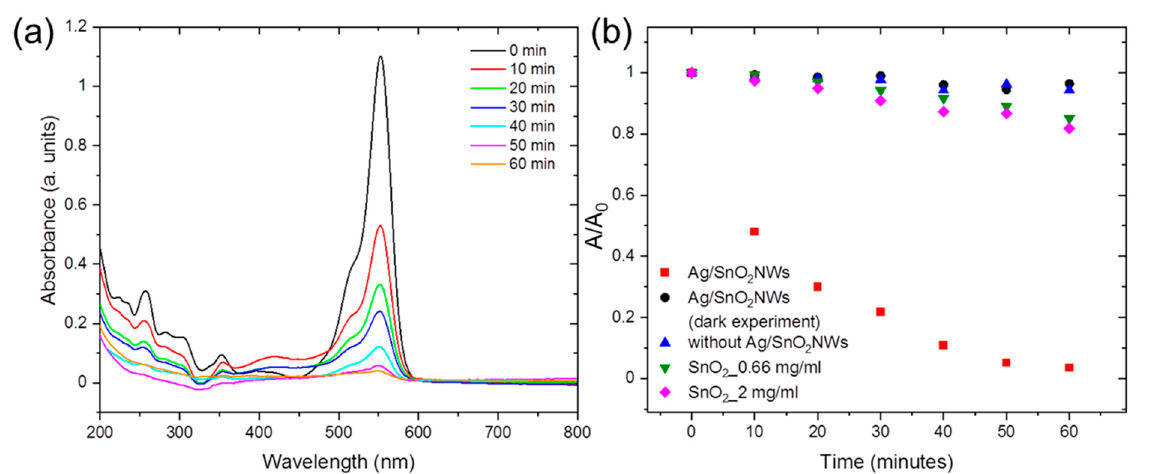
Figure 3. ( a ) The absorbance spectra of rhodamine B with Ag/SnO 2 NWs photocatalyst presence under 395 nm light irradiation. ( b ) The degradation of rhodamine B with 2 mg/mL of Ag/SnO 2 NWs catalyst ( ■ ), without photocatalyst ( ▲ ), with 0.66 mg/mL ( ▼ ), and 2 mg/mL ( ◆ ) of SnO 2 NPs under 395 nm light irradiation and Ag/SnO 2 NWs without irradiation (dark experiment, ● ).